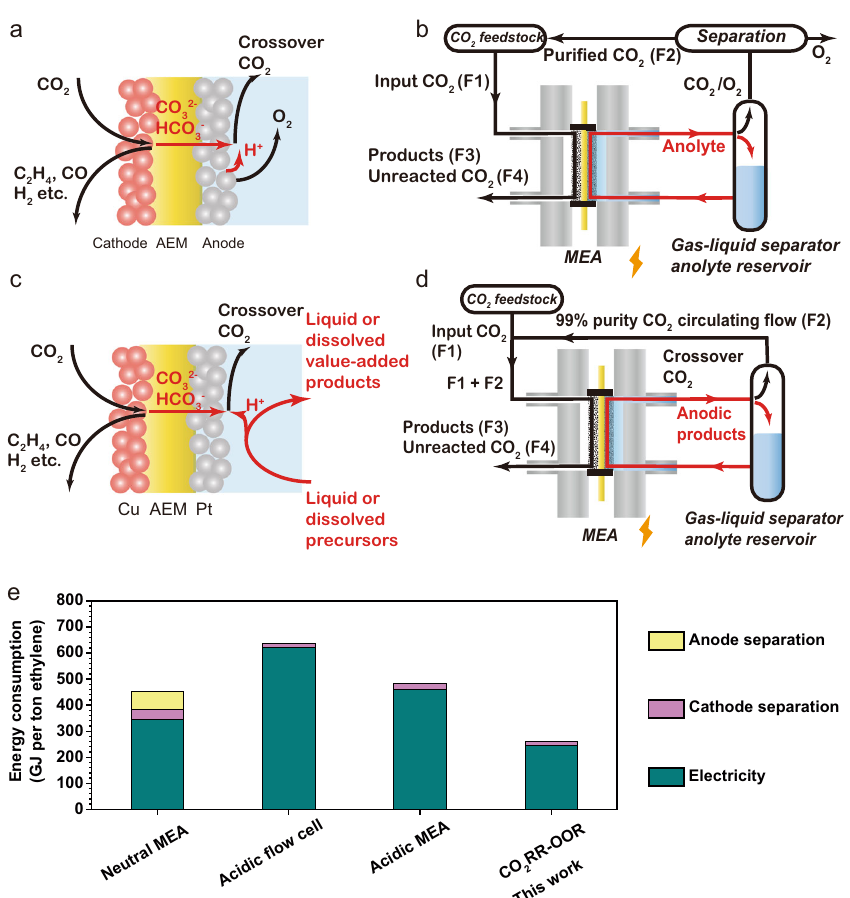
Fig. 1 All-liquid anode enabling CO 2 recycling and low energy intensity ethylene. a Mass balance of the electrochemical process in the conventional CO 2 RR-OER electrolysers. b Operating principle of the conventional CO 2 RR-OER electrolysis. F1, F2, F3, and F4 are the CO 2 that: is input, crosses over, is converted to products, and is unreacted, respectively. c Mass balance of the electrochemical process in the CO 2 RR-OOR MEA electrolyser. The MEA-type electrolyser uses a Cu-loaded gas diffusion electrode as the cathode, a Pt/C loaded hydrophilic carbon cloth as the anode, and an anion-exchange membrane (AEM) as the solid-state electrolyte. At the cathode, some CO 2 is electrochemically converted to CO 2 RR products, and a signi fi cant fraction of CO 2 is converted to carbonate/bicarbonate due to the high local pH. The carbonate/bicarbonate ions then migrate to the anode through the AEM. An organic precursor is electrochemically oxidized to value-added product(s) in a near-neutral electrolyte and generates protons at the anode. The protons combine with the carbonate/bicarbonate ions, regenerating CO 2 as the only gas-phase product at the anodic product stream. d The operating principle of the CO 2 RR-OOR electrolysis system combines low-energy input and high-carbon utilization in CO 2 -to-C 2 + conversion. The system uses an anolyte composed of KHCO 3 and liquid organic precursors. The cathode chamber is fed with humidi fi ed CO 2 . The mass balance table is provided as Table S1. e Energy intensity of ethylene production in benchmark systems from literature (Neutral MEA 4 ; acidic fl ow cell 14 ; acidic MEA 21 ) versus